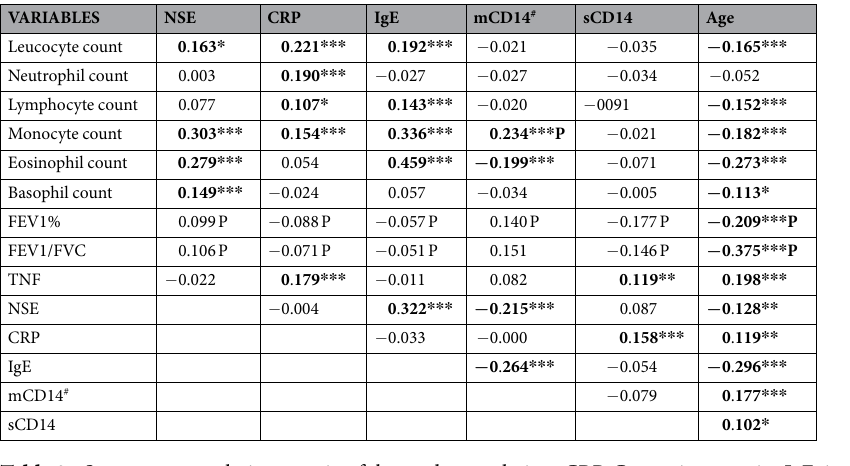
Table 2. Spearman correlation matrix of the study population. CRP, C-reactive protein; IgE, immunoglobulin E; NSE, neuron specific enolase; P, patient population; TNF, tumour necrosis factor. * P < 0.05, ** P < 0.01, *** P < 0.001. # % of CD14 + monocytes.